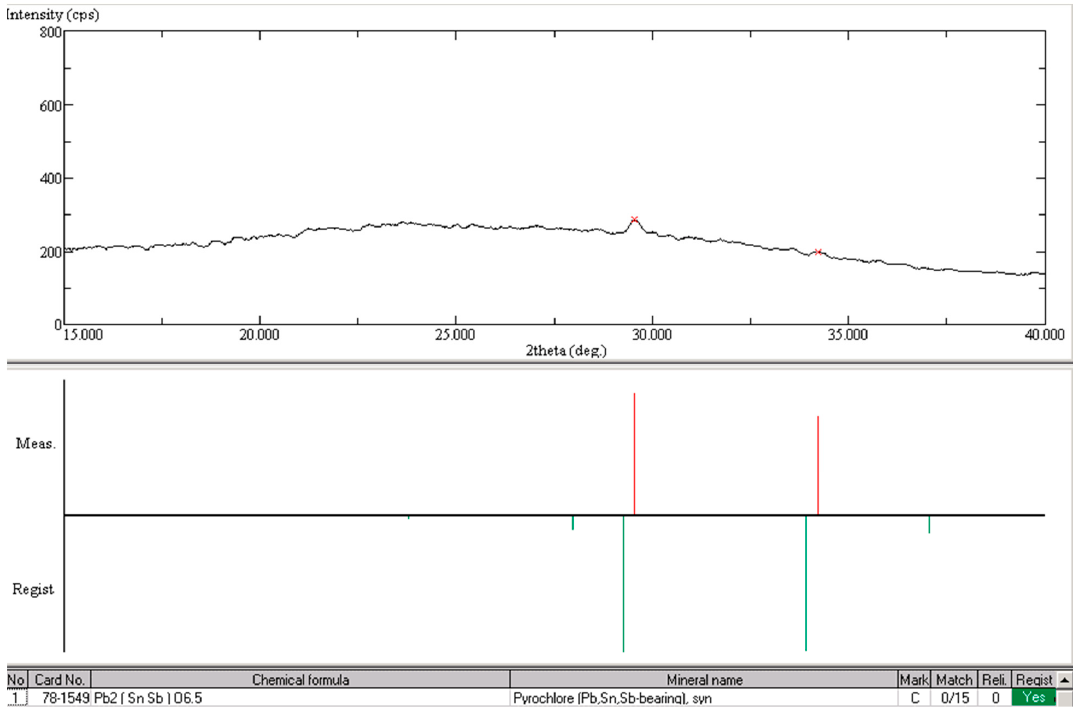
Figure 18. X-ray diffraction pattern compared to generic syntetic pyrochlore containing lead, antimony, and tin. Only the main peak could be detected in the analyzed sample (DMS_11 green/yellow sample from the Great Mosque of Damascus, Syria—unpublished data [24,25]).